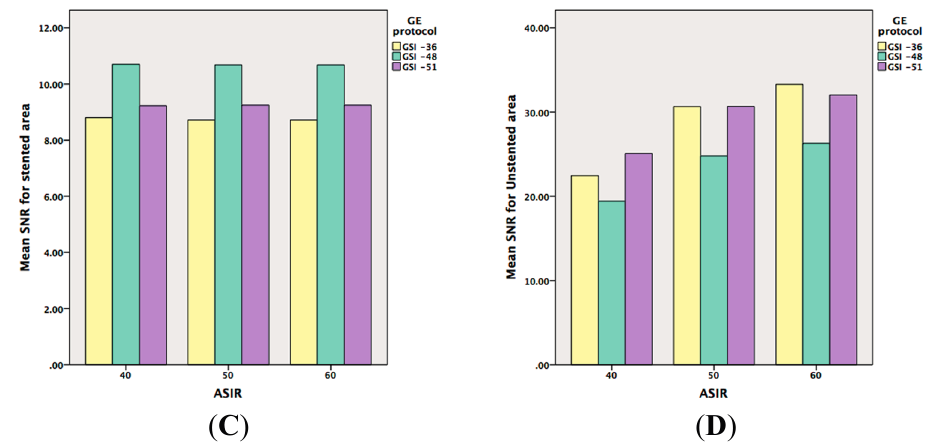
Figure 4. ( A , B ) are graphic representations showing the noise level when ASIR is used within the both unstented and stented areas; while ( C , D ) represent the means of SNR when ASIR is